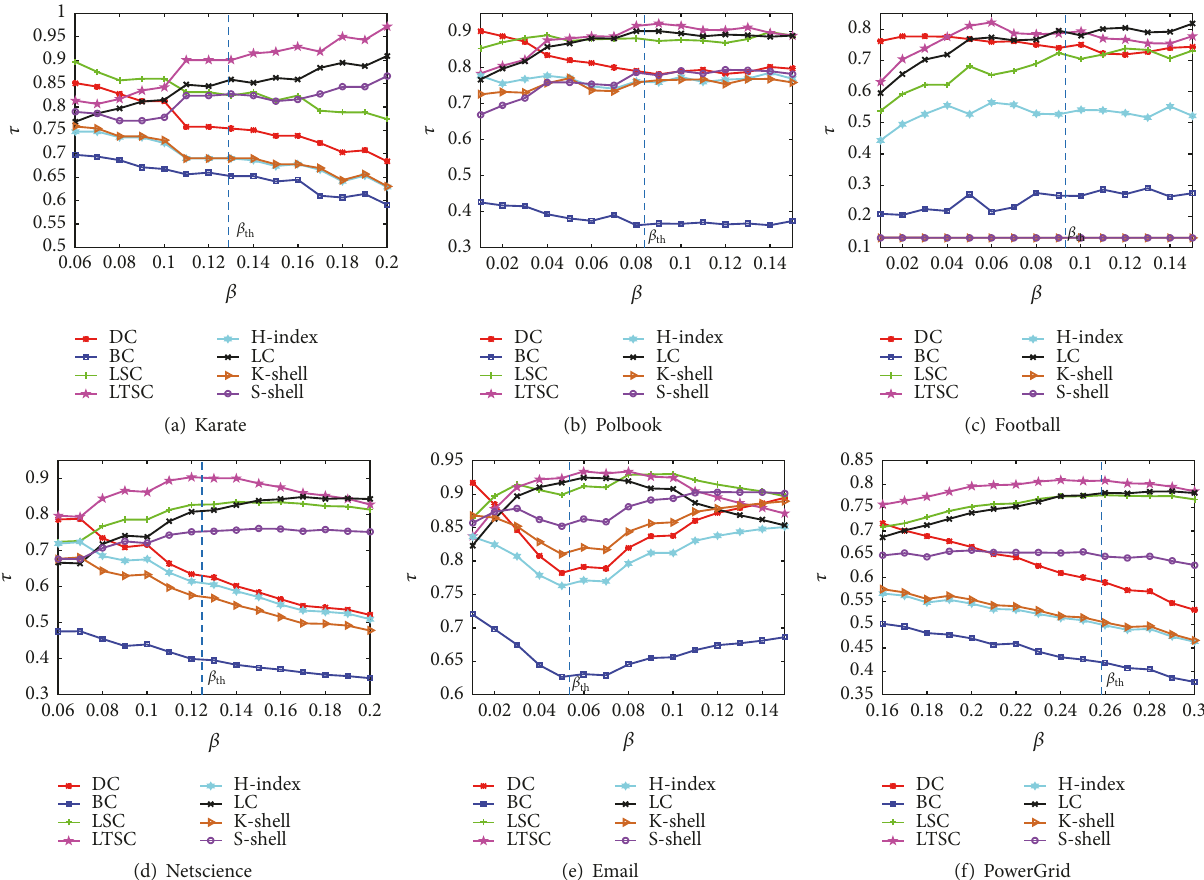
Figure 3: Kendall’s 𝜏 coefficients of the rank obtained by the eight indexes and the rank got by the SIR model with infection probability 𝛽 , where the indexes are LTSC, DC, BC, LSC, H-index, LC, K-shell, and S-shell.